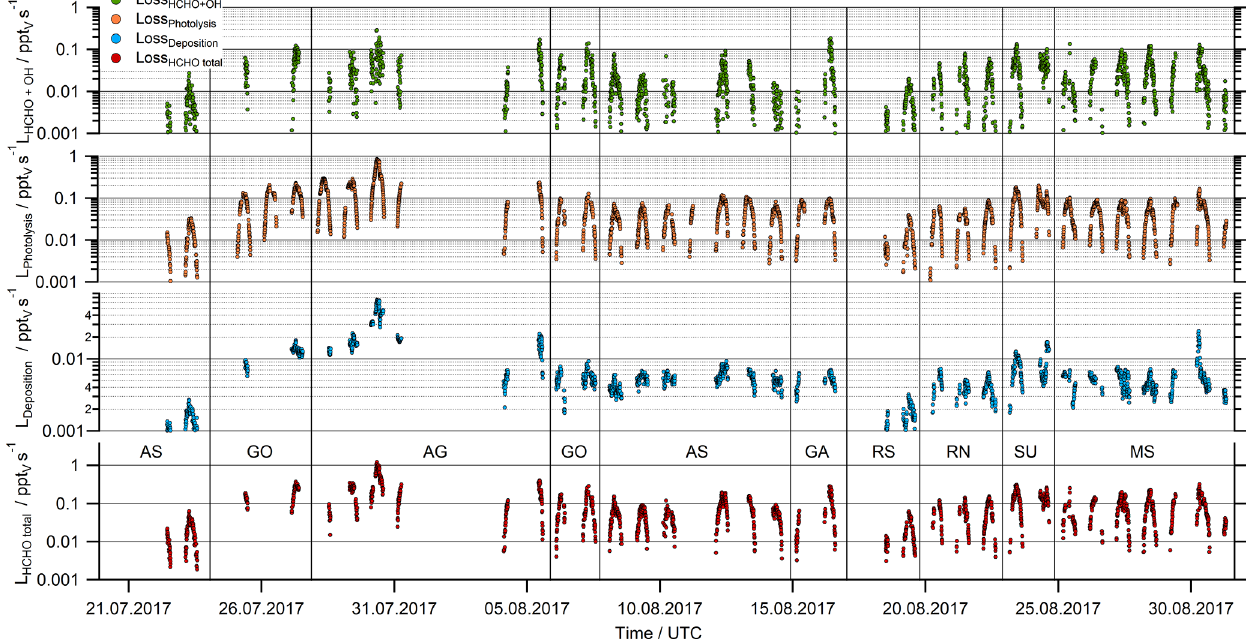
Figure 3. HCHO loss rates due to reaction with OH, photolysis, dry deposition and the total sink as the sum of all three processes.